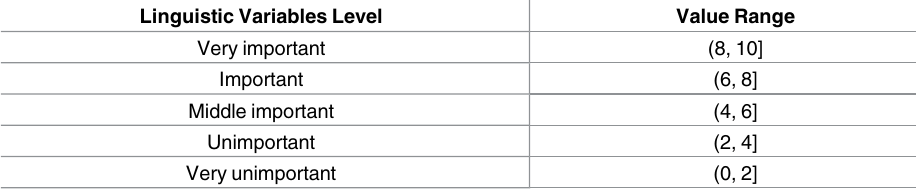
Table 1. Judgment criterion of experts for index